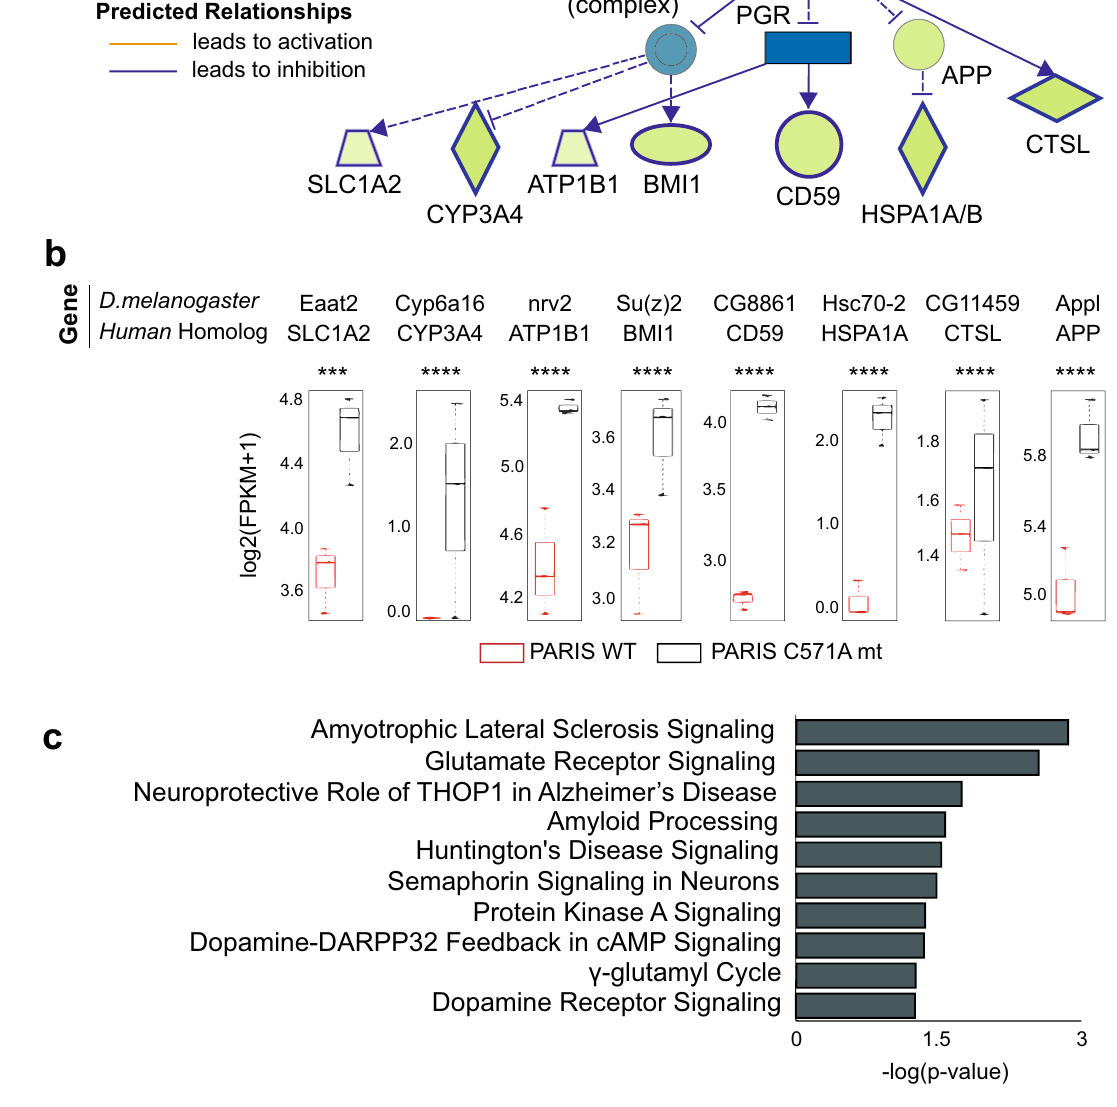
Figure 3 . Multifactorial transcriptomic changes induced by PARIS identify PPARγ as a master regulator. ( a ) The PPARγ network enriched in the input dataset (i.e. human orthologs of the DEGs identified as downregulated from “PARIS C571A mutant versus PARIS wild type” comparison) using Causal Network Analysis (CNA) tool in IPA 34 . Blue arrows indicate a direct, suppressive relationship (such as causation, phosphorylation, and so on) while dashed arrows indicate an indirect relationship. Blue dashed lines without arrow indicate an indirect inhibition, likely by ubiquitination. Green nodes represent user-supplied genes (that is, downregulated in PARIS wild type) while the other nodes are predicted genes. Dark blue shading means the node is predicted to be inhibited by its regulator with high confidence (such as PGR) while pale blue shading means inhibitory prediction with low confidence (such as NFkB). Network shapes: rectangle (nuclear receptor), vertical diamond (enzyme), horizontal diamond (peptidase), ellipsis (transcription regulator), trapezoid (transporter), circle (other). Enrichment (FET) p value threshold: 1e−03. ( b ) The expression profile of the user- supplied genes in the PPARγ network in ( A ) with statistical significance values: *** p ≤ 0.001, **** p ≤ 0.0001. As expected, all these genes with plotted expression profiles are downregulated with high significance in PARIS wild type with respect to the mutant. ( c ) Enriched canonical pathways with a strong emphasis on neurodegeneration identified by Canonical Pathway Analysis (CPA) module in IPA 34 taking the same human ortholog genes in ( A ) as